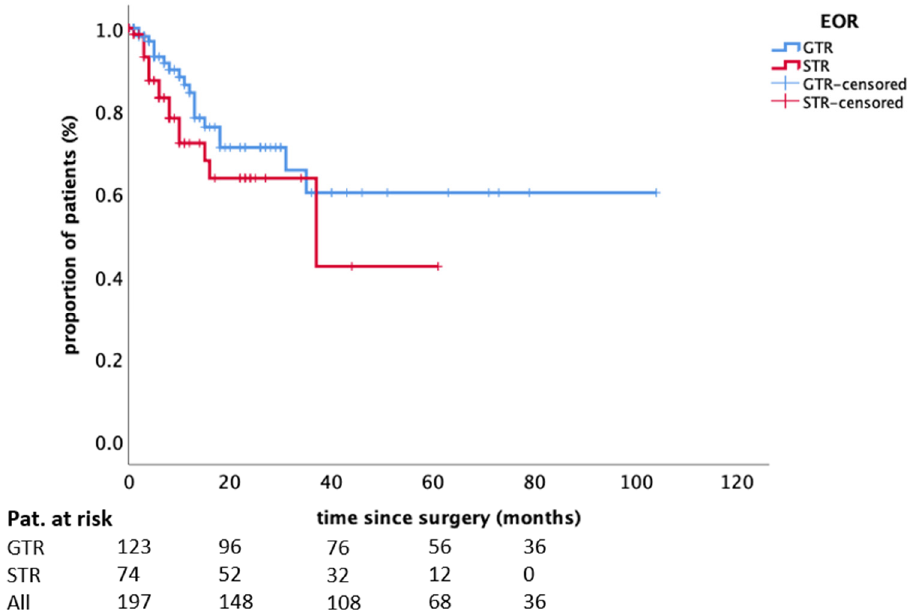
Figure 1. The influence of the extent of resection on local recurrence. Kaplan–Meier plot ( n = 197; incomplete/complete: 74/123; p = 0.1395). Abbreviations: EOR—extent of resection, GTR—gross-total resection, STR—sub-total resection.